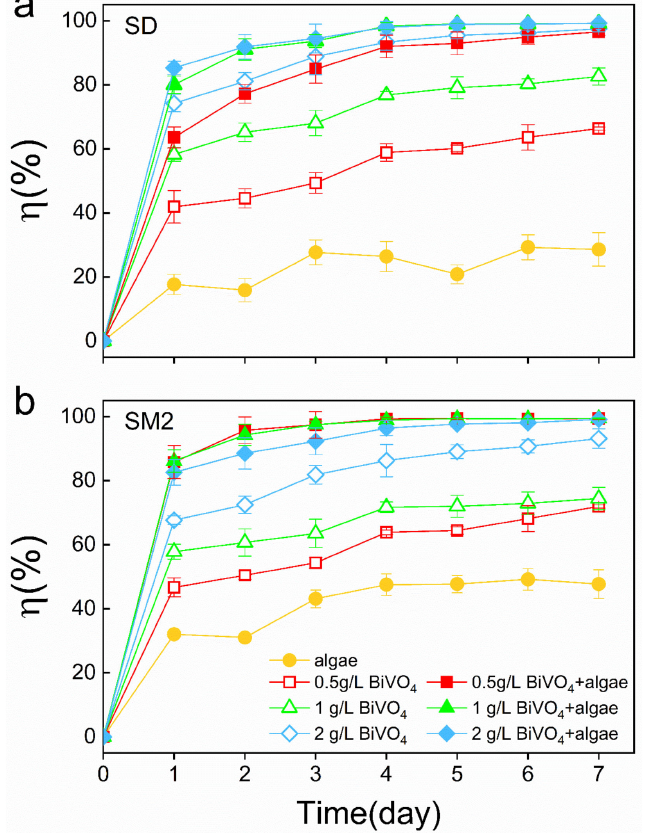
Figure 1. Effect of the treatment group (BiVO 4 –algae) and control groups (algae and BiVO 4 ) on the removal of SD ( a ) and SM2 ( b ) during the